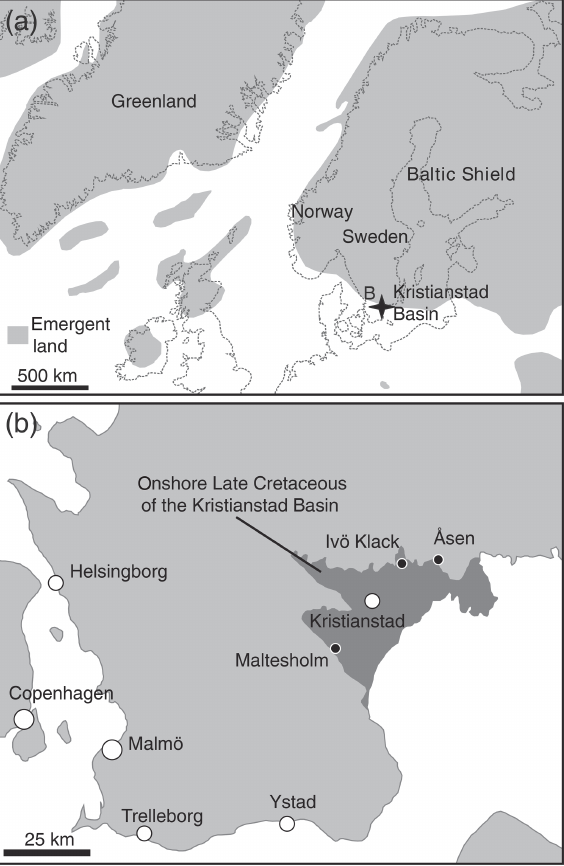
Figure 1. Paleogeographic map of the Boreal Chalk Sea (a) and the area of present-day southern Sweden (b) showing the location of Ivö Klack (modified after Sørensen et al.,